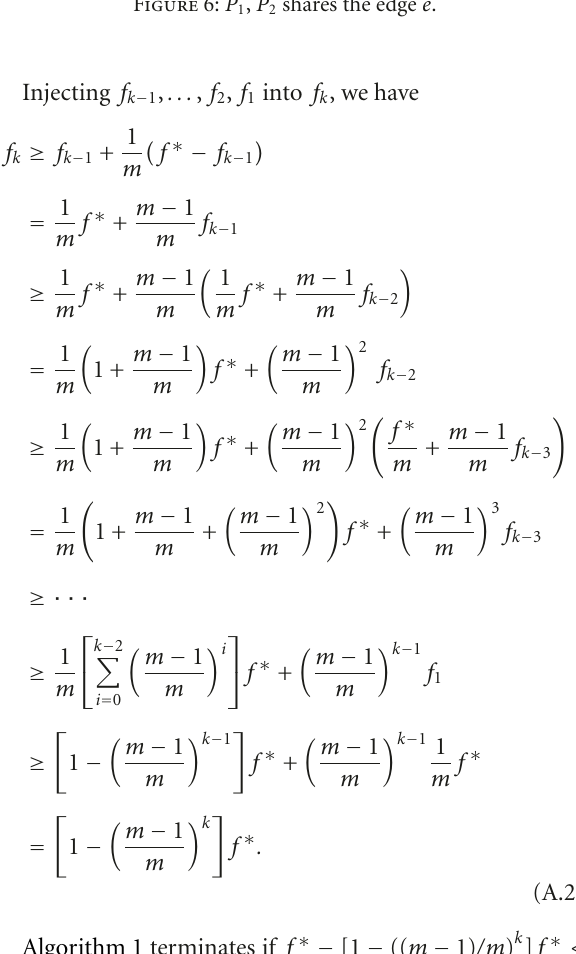
Figure 5: Two paths forms a cycle.